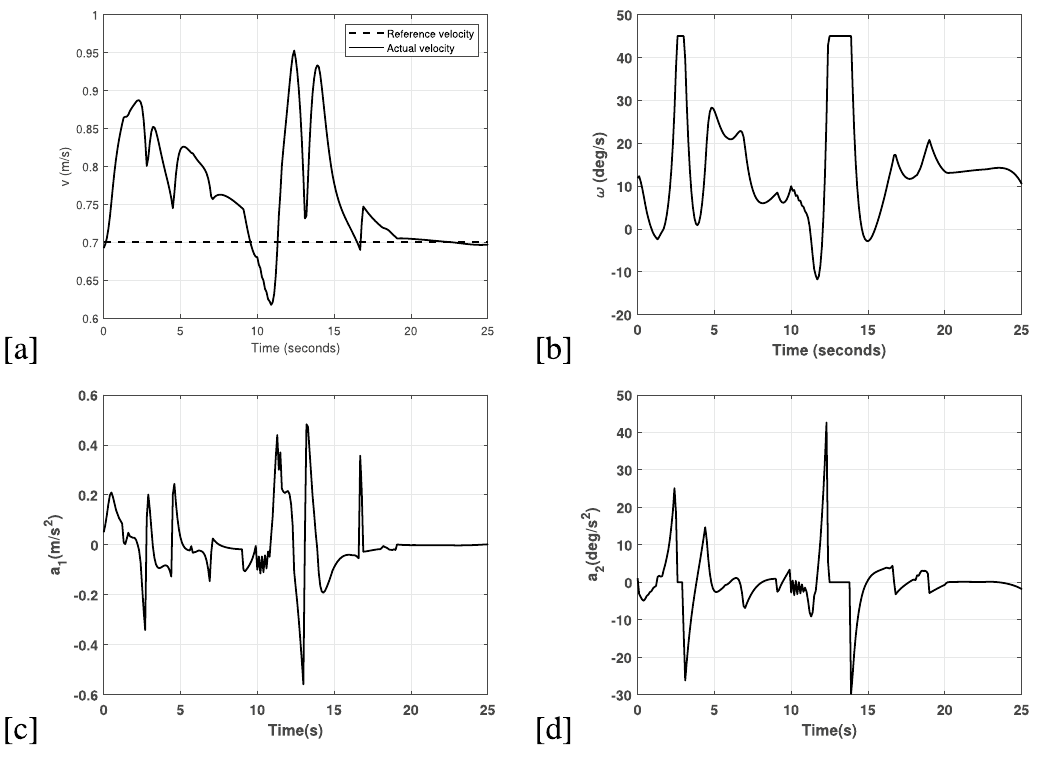
Figure 5. ( a ) Longitudinal velocity applied to the UGV in the simulation experiment 3. ( b ) Angular velocity applied to the UGV in the simulation experiment 3. ( c ) Rate of change in the longitudinal velocity applied to the UGV in the simulation experiment 3. ( d ) Rate of change in the angular velocity applied to the UGV in the in the simulation experiment